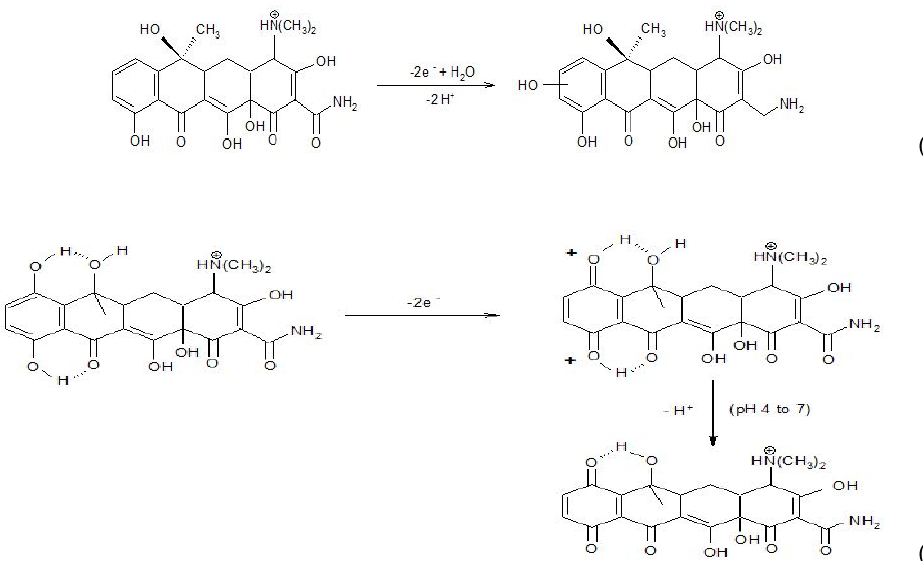
Figure 7. ( a ) CVs recorded at 0.050 V · s − 1 scan rate on BDD/GO/Ag in 0.1 M Na 2 SO 4 supporting electrolyte and in the presence of various TC concentrations: 2–16 µ M TC; potential range: − 0.500 to +1.00 V/SCE; ( b ) Calibration plots of the currents recorded at E 1 = +0.550 V/SCE and E 2 = +0.850 V/SCE vs. TC concentrations.